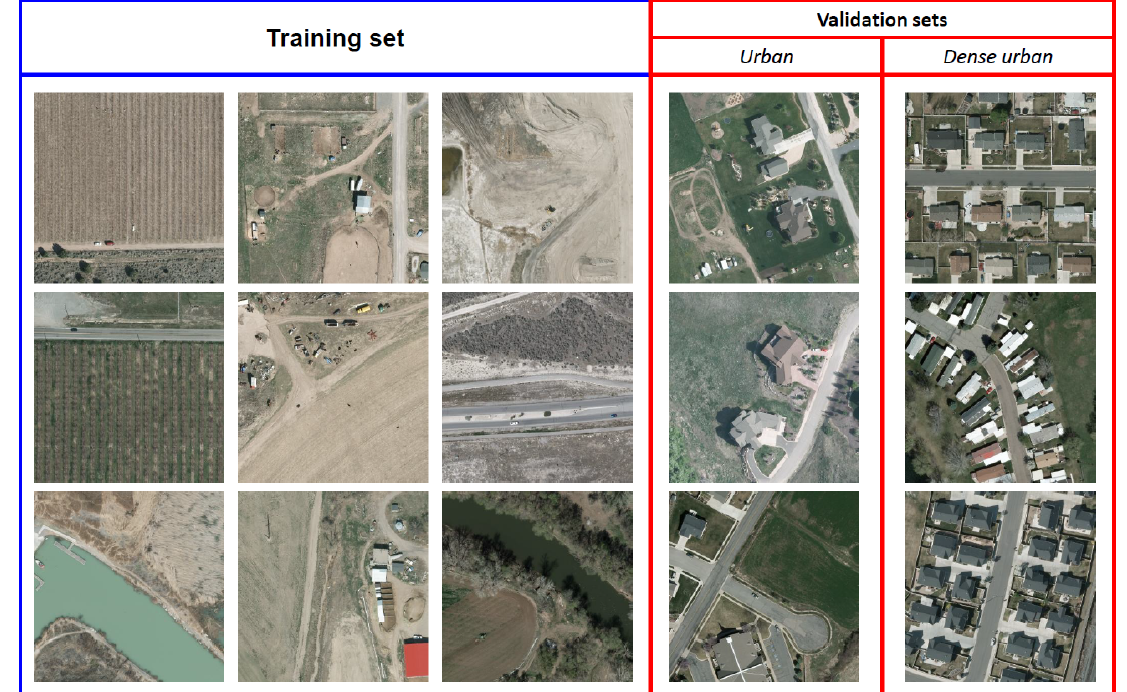
Figure 11. Appearance of new backgrounds in validation sets: the 25-cm VEDAI512 dataset (color version) is divided into three sets: one training set with images acquired in rural, forest, and desert environments; and, two validation sets with new backgrounds from urban and very dense urban